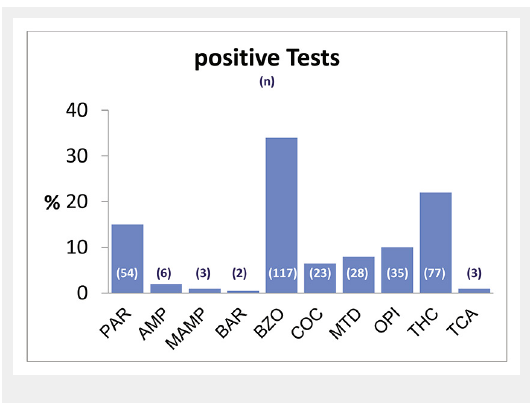
Spectrum of substances detected with the Triage ® TOX screen (204 positive urine samples with 348 substances detected). AMP = amphetamines; BAR = barbiturates; BZO = benzodiazepines; COC = cocaine; MAMP = metamphetamines; MTD = methadone; OPI = opiates; PAR = paracetamol; TCA = tricyclic antidepressants; THC = tetrahydrocannabinoids longer monitoring when methadone